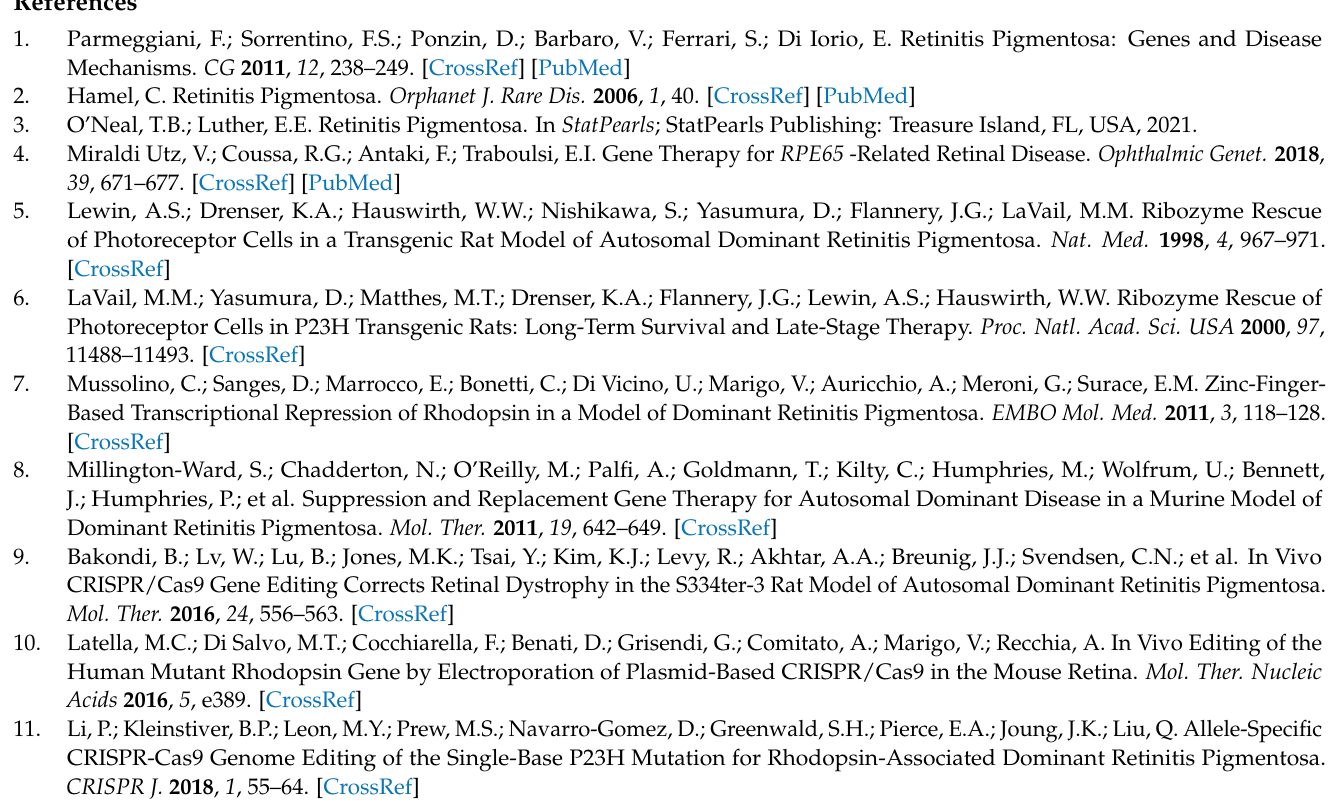
(LE) rats; Figure S4: Quantification of ONL thickness along its rostral–caudal axis up to 2640 µ m in the AAV-treated retina; Figure S5: Assessment of AAV packaging efficiency. Table S1: Predicted on- and off-targets sites for gRNA; Table S2: Primer sequences used for qPCR; Table S3: Frequency of indels and frameshift in AAV-SaCas9/gRNA treated and untreated P23H rats; Table S4: Off-target analysis of CRISPR/Cas9-mediated editing of m-Rho P23H in P23H